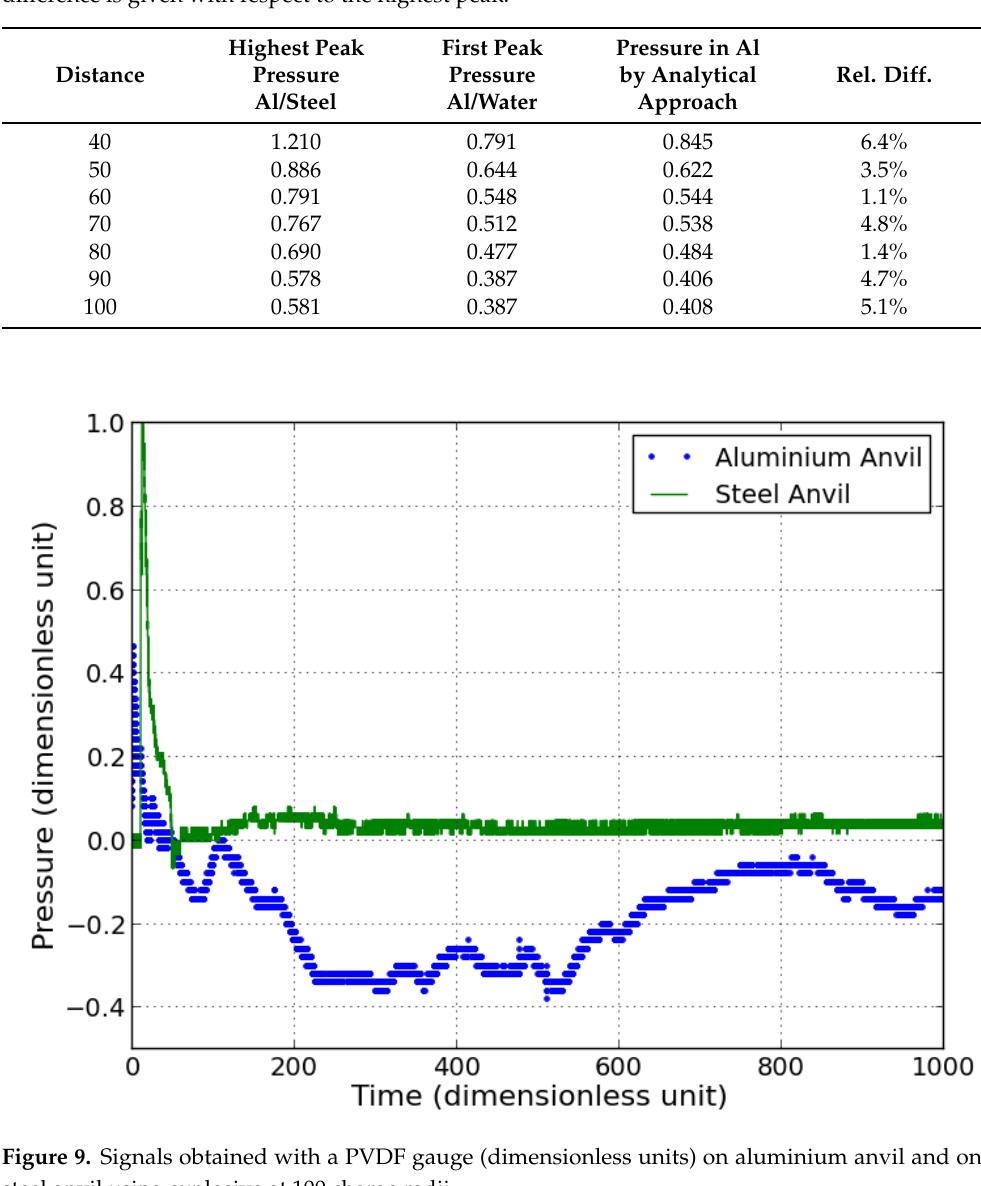
Table 2. Dimensionless peaks of overpressure measured by the sensor at various distances. The high- est peak pressure corresponds to interaction between sensor aluminium shield and steel and the first peak corresponds to the interaction between sensor aluminium shield and water. The relative difference is given with respect to the highest peak.